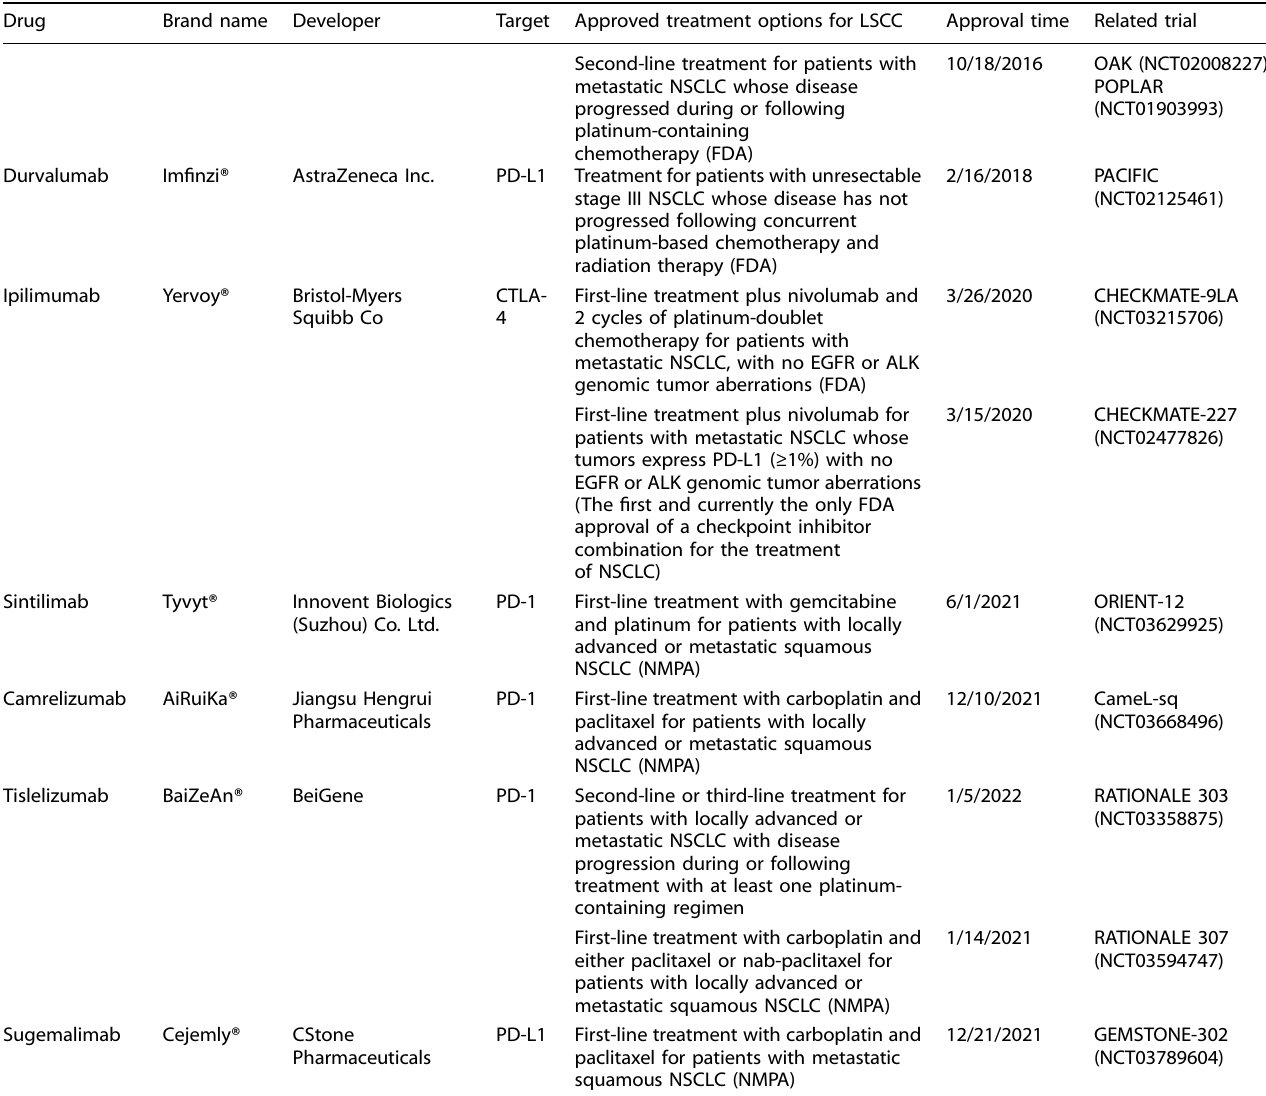
CTLA-4: the fi rst clinically targeted immune-checkpoint receptor CTLA-4 is a homolog of CD28 and binds both B7-1 (also known as CD80) and B7-2 (also known as CD86) with much higher af fi nity than CD28. 336 – 339 The CTLA-4 and CD28 genes are located in the same region of chromosome 2 (2q33.2) and are expressed by both CD4 + and CD8 + T cells with opposing functions in T-cell activation. 337,339 Through interacting with a pair of ligands (B7-1 and B7-2) expressed on antigen-presenting cells (APCs), including macrophages, dendritic cells (DCs) and B cells, CD28 mediates T-cell activation by co-stimulating T-cell receptor (TCR)